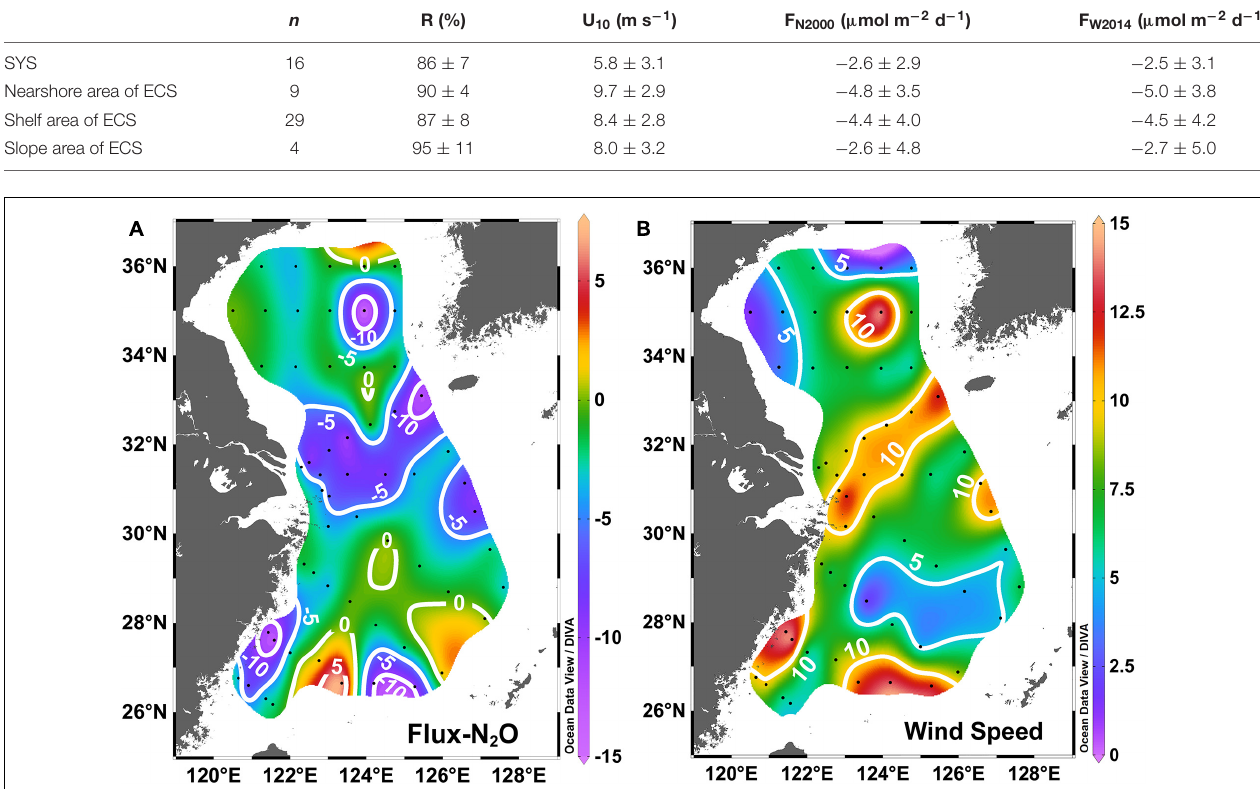
to 22.4 nmol L − 1 of N 2 O and − 1.6 to − 1.8 µ mol L − 1 of N